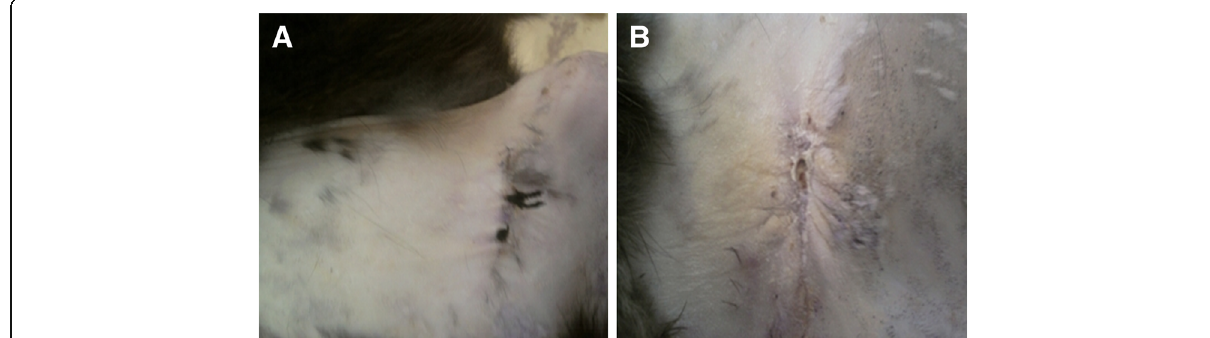
Fig. 2 a Crush site of sciatic nerve in the treated group. b Untreated rabbit wound